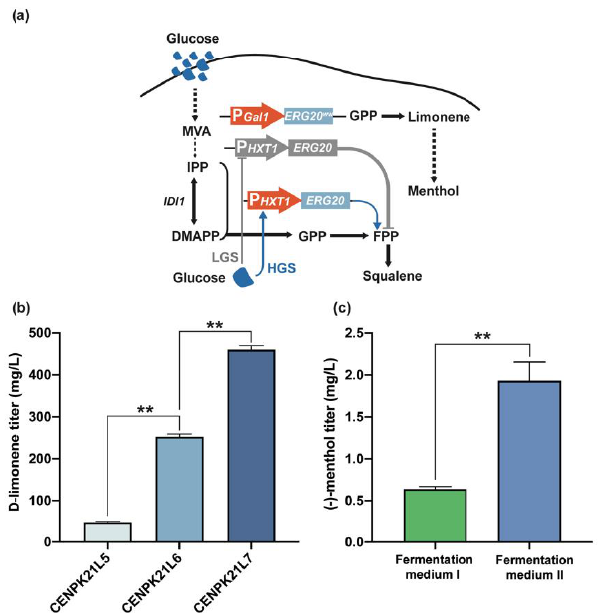
Figure 3. Dynamic regulation of ERG20 gene expression. ( a ) Dynamic regulation strategies for (−) - menthol synthesis. The native promoter of chromosomal ERG20 was replaced with the HXT1 promoter. Arrows represent positive regulation, and blunt-ended lines represent negative regulation. LGS: low glucose, HGS: high glucose. ( b ) Dynamic regulation of ERG20 by P HXT1 increased the limonene titer by 3.5 times. Increasing the copy number of ERG20 ww and tLims could further increase the limonene titer to 459.59 mg/L. ( c ) Optimized fermentation medium is more conducive to (−) -menthol production than nonoptimized fermentation medium. Statistical significance is indicated as ** for p < 0.01.